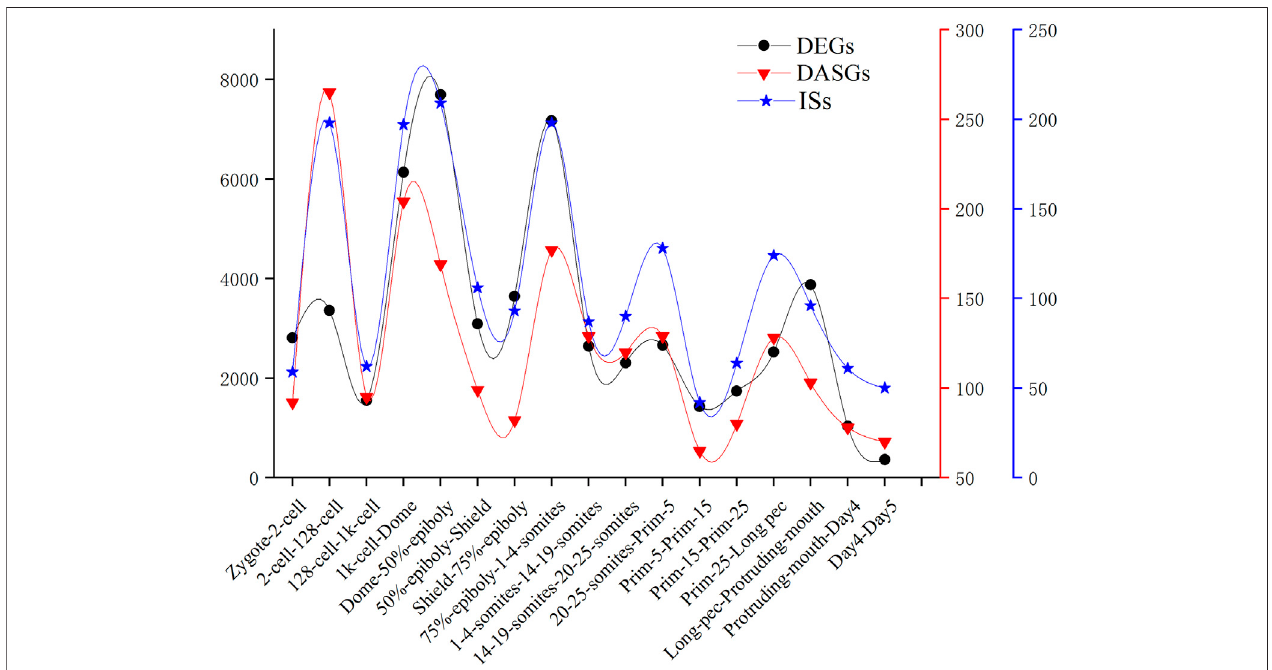
FIGURE 7 | The number of DEGs, DASGs, and IS for every consecutive stages of embryo development. DASGs represent genes in which differential alternative splicing events was identi fi ed.